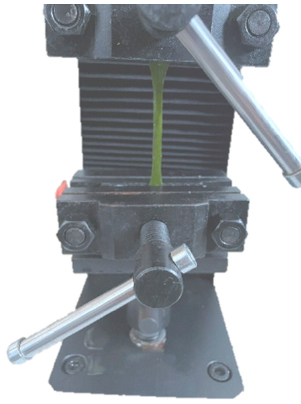
Figure 4. Schematic diagram of tensile test